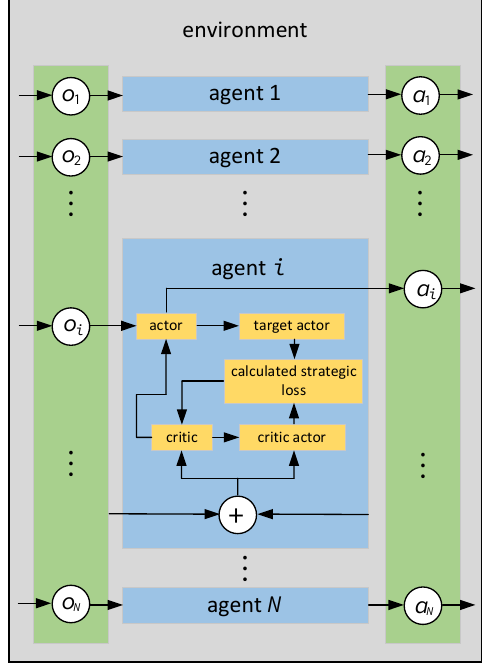
Figure 2. MADDPG algorithm training framework diagram.